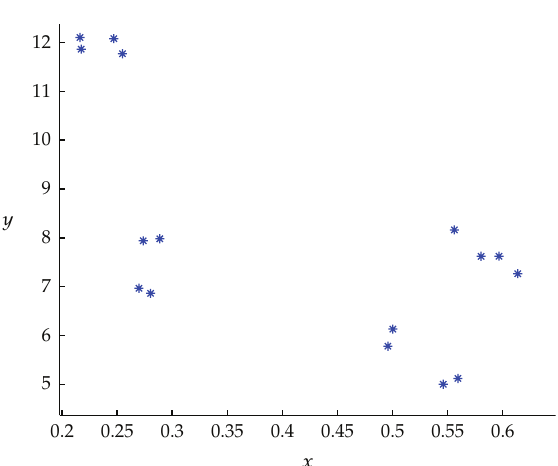
Figure 11: A stable 16-cycle around the R4 point of Run 9 for a (cid:8) 4 . 68, b (cid:8) 0 . 2, and d (cid:8) 2 .